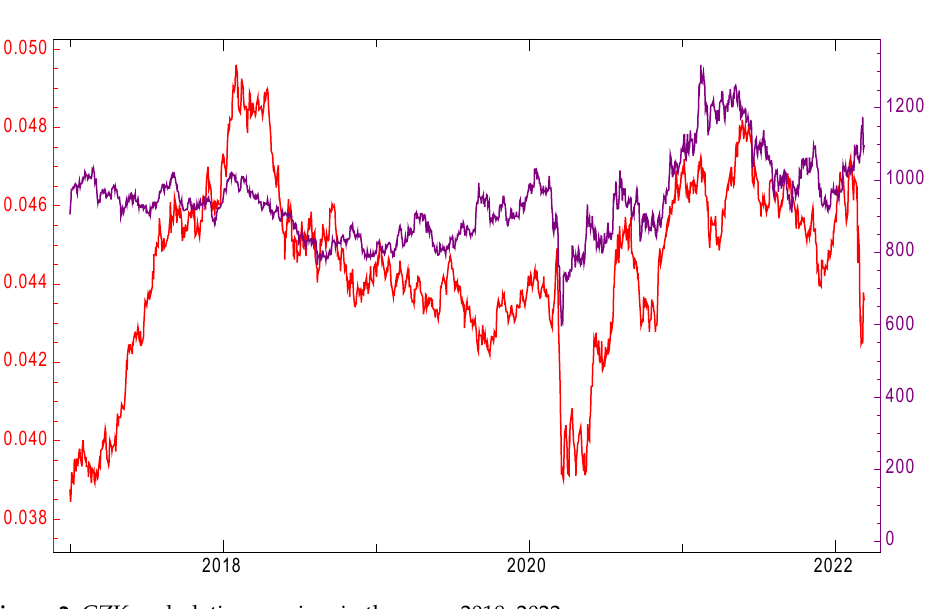
Figure 2. CZK and platinum prices in the years 2018–2022. The two-sided chart shows the price of CZK and platinum in the years 2017–2022. The red curve represents the CZK price, while the violet curve is the price of platinum. The left vertical axis expresses the CZK price in USD, the right one the price for troy ounce of platinum in USD. The graph shows that the CZK price changed significantly in the monitored period, ranging from USD 0.0385 to 0.045 (i.e., by almost 15% in relative terms). The highest price of CZK was recorded in 2018, achieving the aforementioned USD 0.045. In 2019, the price decreased, achieving its minimum in 2020 (USD 0.0385). In the years 2021 and 2022, the CZK price grew. The price of platinum was very volatile. In the first years of the monitored period, the price was USD 800—1000 per troy ounce. In 2020, commodity dropped below USD 600, then rocketed to more than UD 1300 per troy ounce in the first quarter of the year 2022. The relative change in the price of the precious metal for a year and a quarter is thus more than 50%. The day-on-day changes in prices are shown in Figure